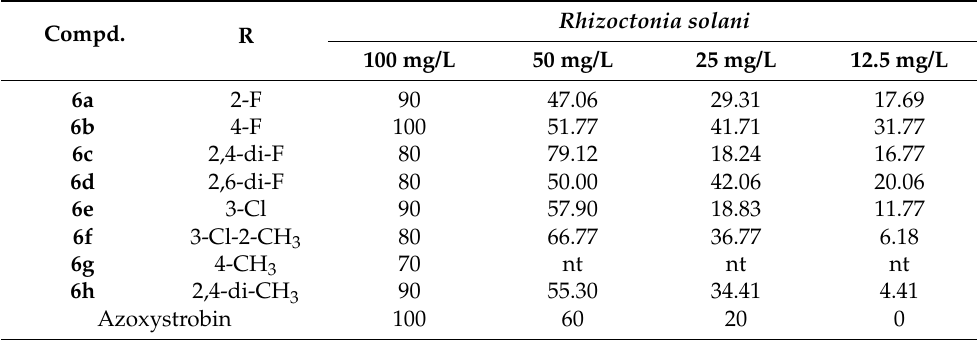
Note: nt = not tested. All the data were determined three times.